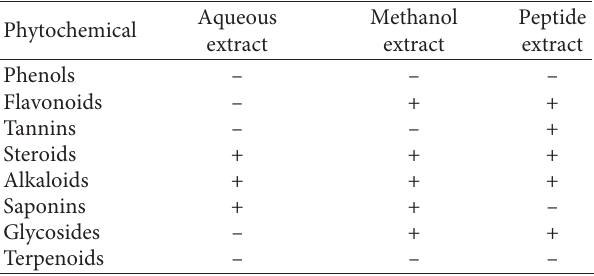
Table 2: Results of the phytochemical screening of the three ex- tracts of soybean